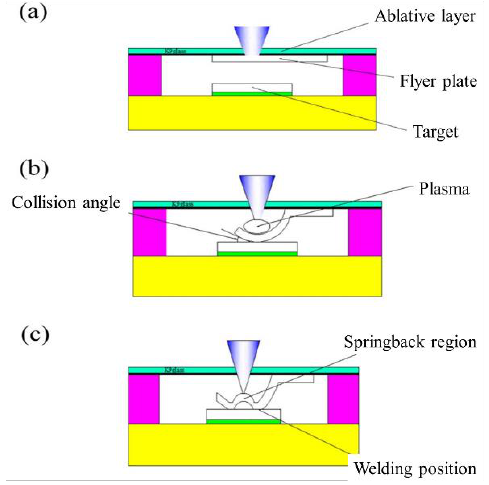
Figure 4. Schematic diagram of laser impact welding process (reproduced from [28], with permission of Elsevier 2019). ( a ) Excitation stage: The laser irradiates the ablation layer through the confinement layer, and the ablation layer is vaporized into plasma. Due to the limitation of the confinement layer, the reaction force of the plasma drives the flyer to emit; ( b ) Flight phase: the flyer passes the preset flight distance (standoff) and collides with the target at a certain speed and angle; ( c ) Welding stage: The behavior of the impact point is shown in Figure 5 (the welded area on the left). The flyer and the target collide at a certain angle from the starting position of the metallurgical bonding to the end position and the welding is over.